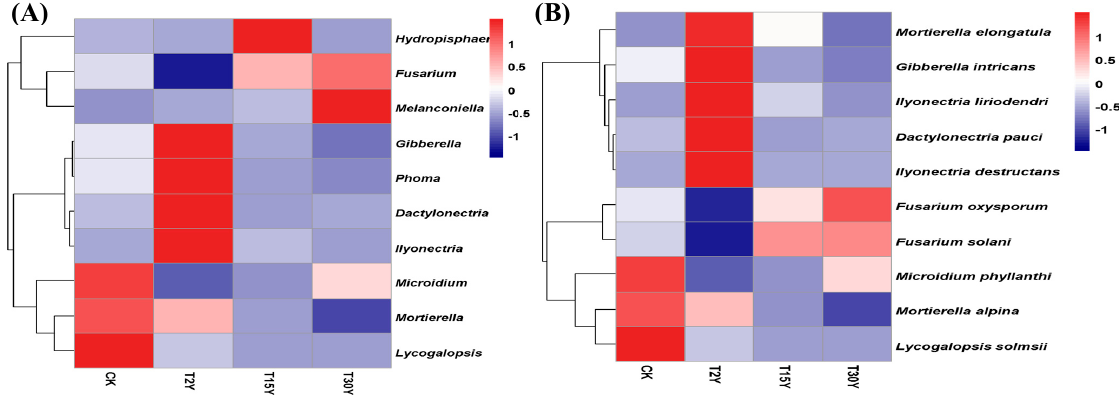
Figure 5. Composition and distribution of 10 dominant ( A ) genera and ( B ) species in soil obtained from control and different age monoculture tea fields. The color code displays relative abundance, ranging from red (high abundance) to blue (low abundance). CK, T2Y, T15Y, and T30Y represent fields consecutively planted for 0, 2, 15, and 30 years, respectively.